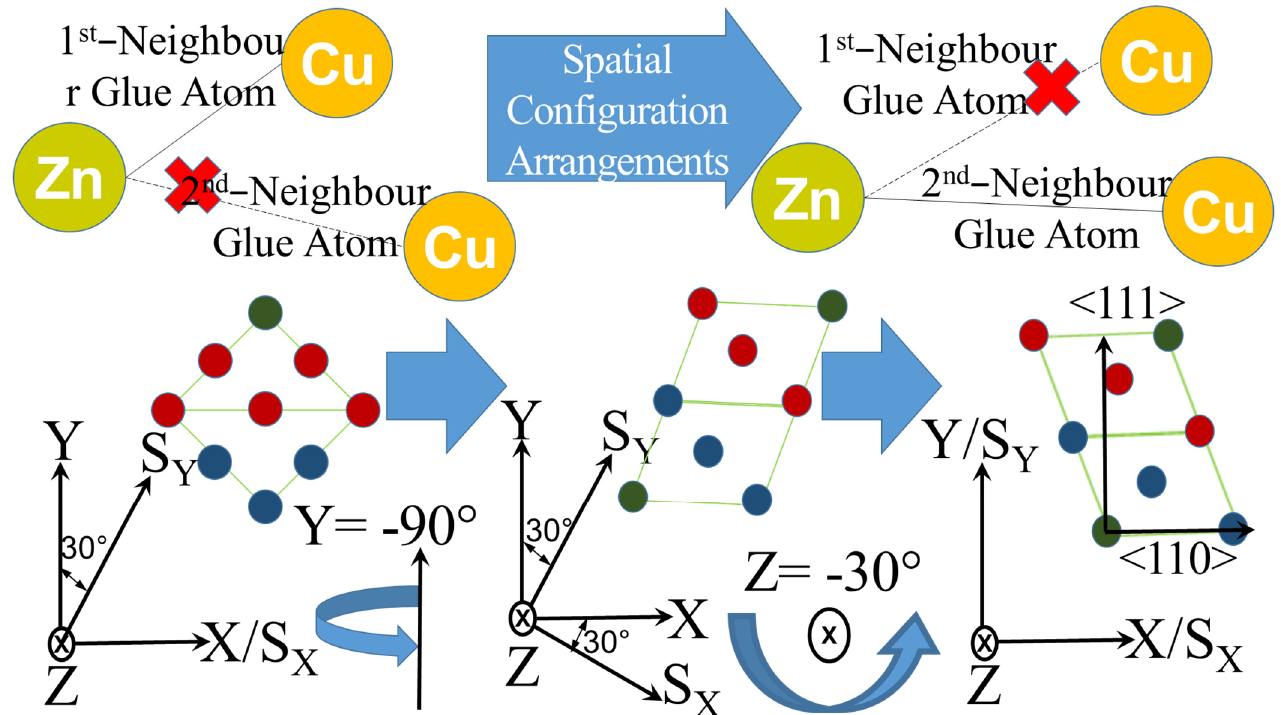
Scheme 4. Illustration of spatial configuration arrangements ( top ) and the evolution of lattice plane distortion by the shear–strain axis rotation and three-colour sphere balls in crystal structure ( bottom ).